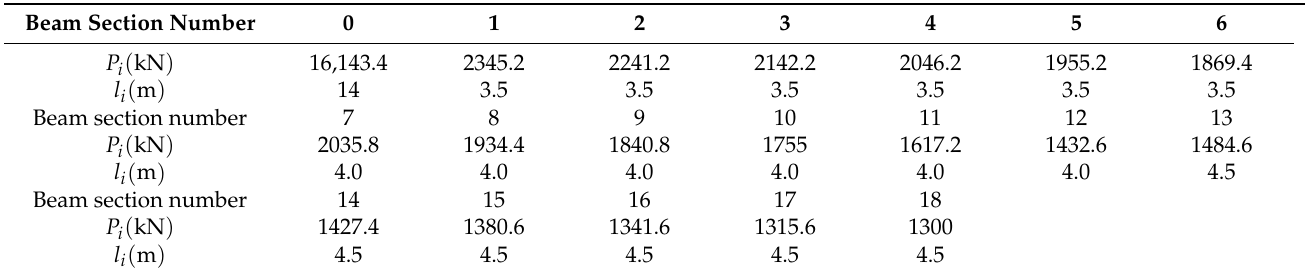
Table 1. Weight and length of suspended beam section of Pier 8#.